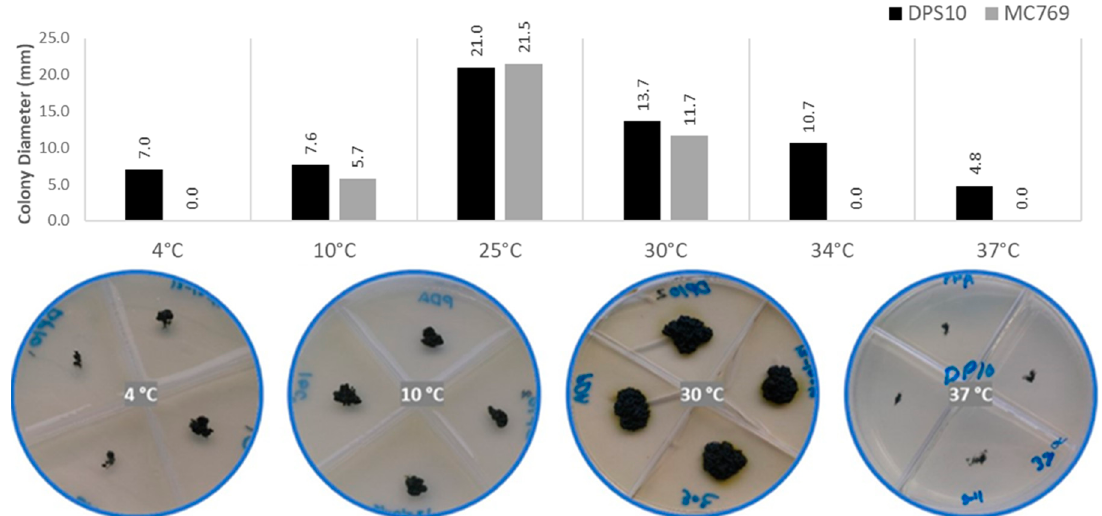
Figure 3. Temperature preferences of Pseudotaeniolina globosa DPS10 isolate shown by the colony diameter reached on PDA medium after one ‐ month incubation. The column chart in the upper part exhibit comparison of DPS10 and MC769 isolates at 4, 10, 25, 30, 34, and 37 °C. Visual examination of the colonies in the lower part shows the growth of DPS10 at 4, 10, 30, and 37 °C in quadruplicates (Petri dish of four divisions). Data on MC769 isolate come from De Leo et al. [16].